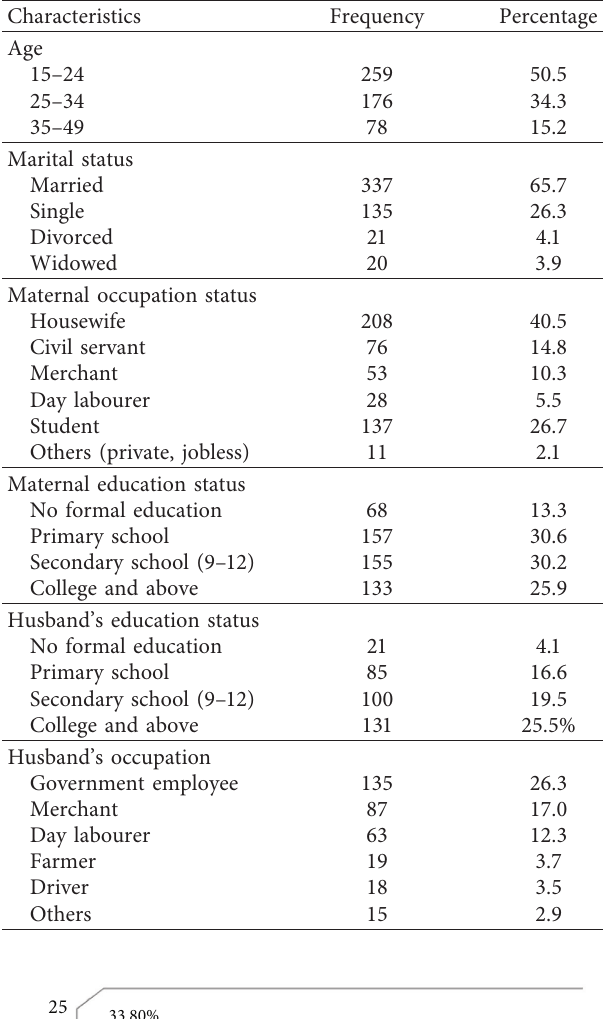
Table 1: Sociodemographic characteristics of the childbearing age group women in Jinka town, Southern Ethiopia, 2018 ( n � 513).